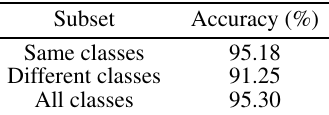
Table 7. Classification accuracies (%) on the target datasets obtained by transfer learning using the domain-adapted models. FE denotes using domain-adapted models for feature extraction and FT fine-tuning the domain-adapted model.